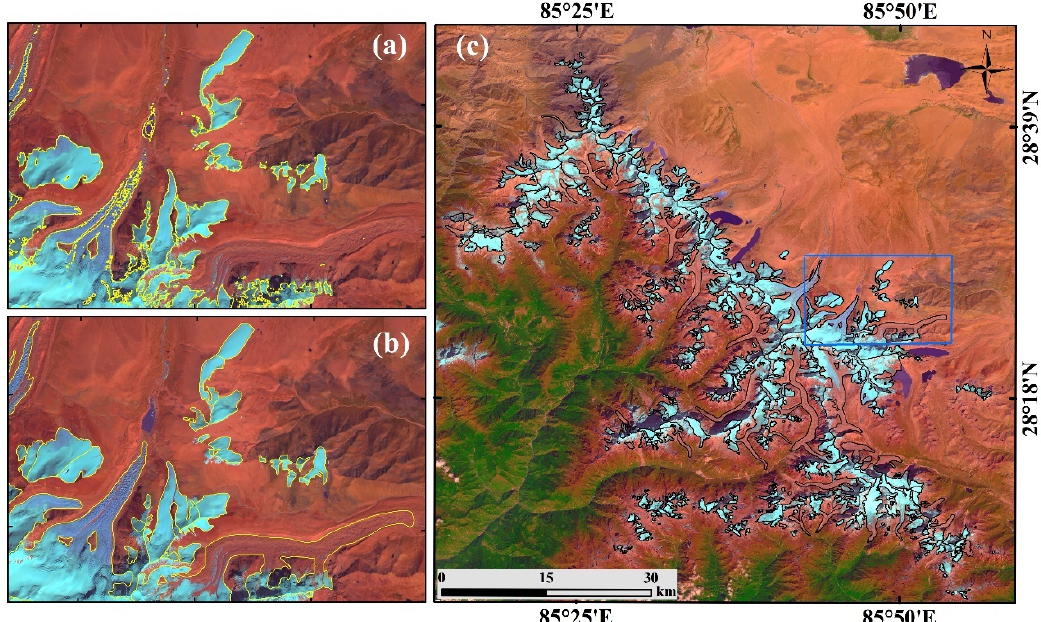
Figure 3. Subfigures ( a , b ), respectively, represent the automatically extracted glacier outlines and manually edited glacier outlines in 2018. Subfigure ( c ) is the 2018 glacier outline map of Xixabangma massif. The blue rectangle in subfigure ( c ) denotes the position of subfigures ( a , b ).